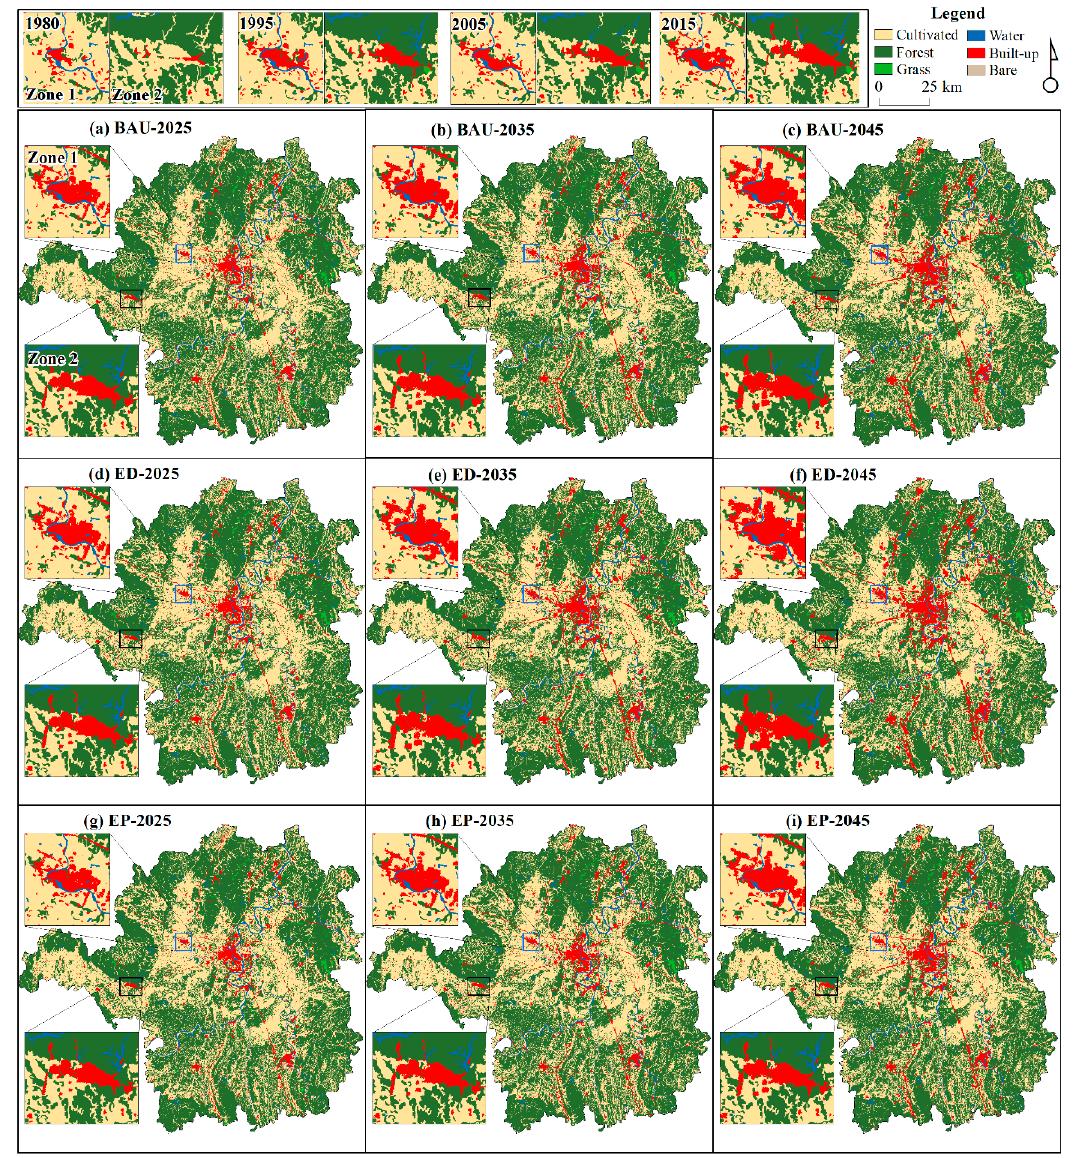
Figure 10. Projected pattern under a multi-scenario in 2025, 2035 and 2045 (BAU: business as usual scenario; ED: economic development scenario; EP: ecological protection scenario). Table 3. The PLUS model prediction results under different scenarios (unit: km 2 ).